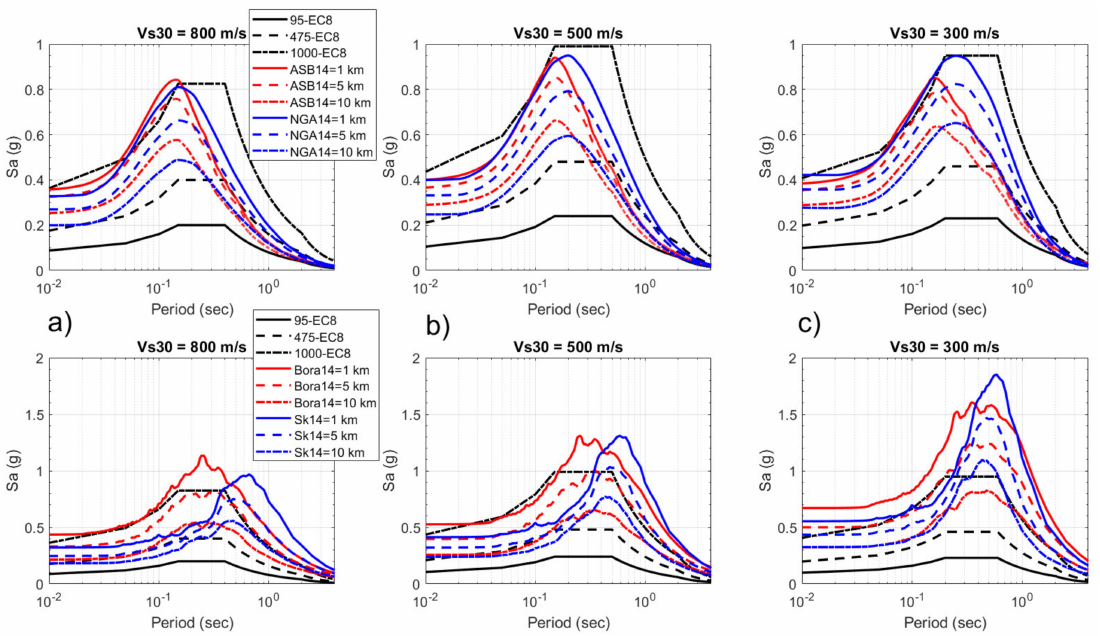
Figure 15. Comparison of EC8-Type 1 spectra based on the CRO hazard maps for the 95 (0.08 g)-, 475 (0.16 g)- and 1000 (0.33 g)-year return periods with response spectra from GMPEs that were derived from the ASB14 and NGA14 (BSSA14 and CY14) models ( upper row ) and RVT spectra that were derived from Bora14and Sk20 ( bottom row ) for site categories: ( a ) 800 m/s (EC8-A), ( b ) 500 m/s (EC8-B), and ( c ) 300 m/s (EC8-C) at close distances of 1 km, 5 km and 10 km from the